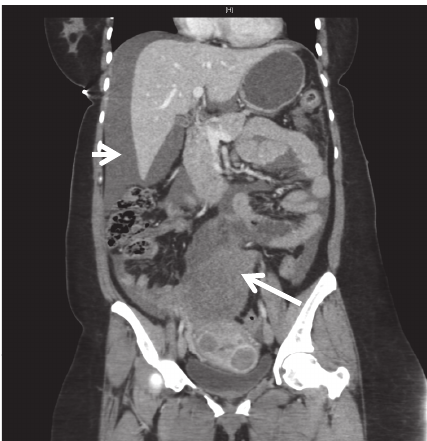
Figure 2: Photograph of the specimen removed. Grossly, approxi- mately 15cm exophytic red degenerated